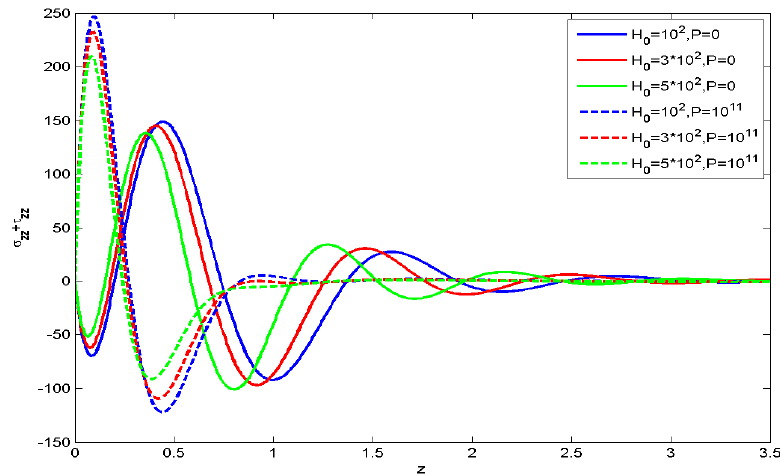
Figure 23. Maxwell stress τ zz concerning z with magnetic field H 0 .